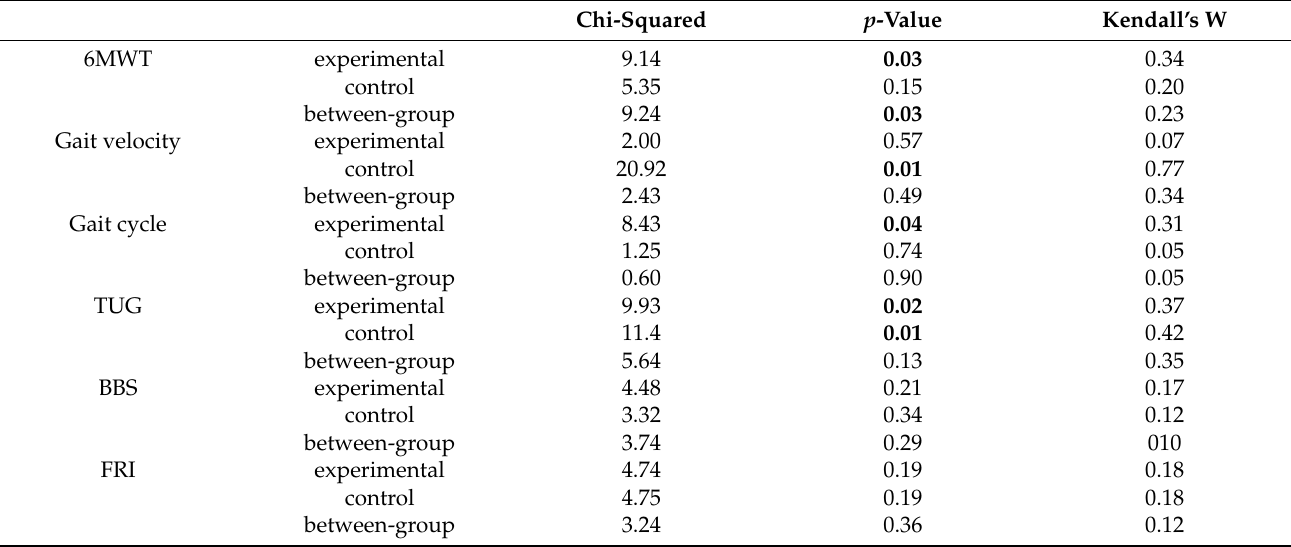
Table 3. Repeated measure differences (Friedman test) in the outcome measures for the experimental (tDCS plus physical therapy) and control (sham tDCS plus physical therapy) groups. p